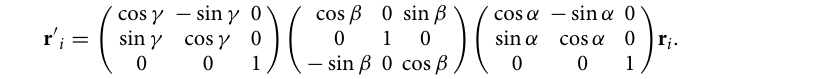
Figure 4. Sphere representing the A647 position predicted by FRET analysis. The orientation factor κ 1.55 obtained from the electronic coupling calculation gives a better prediction of the A647 position than the isotropic mean value of 2/3. Further consideration of the refractive index n to 1.03 leads to a near perfect match with the A647 position in the MD